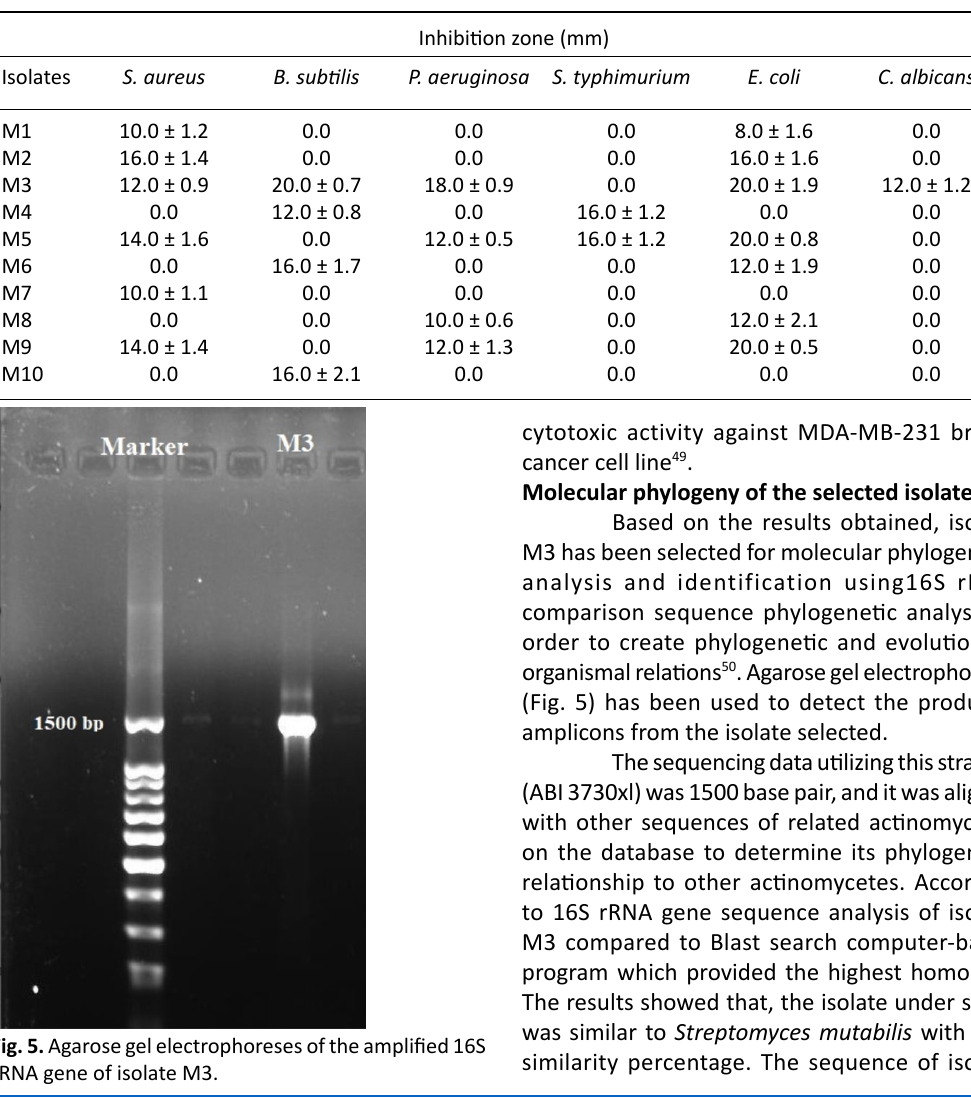
Table 4. Antimicrobial activity of actinomycetes isolates against different pathogens